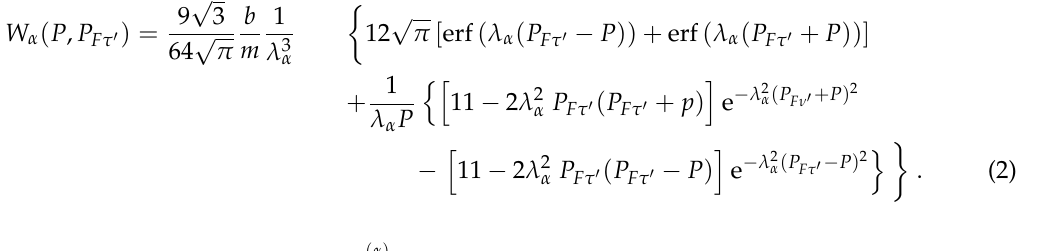
Table 1. Quark exchange coefficients c